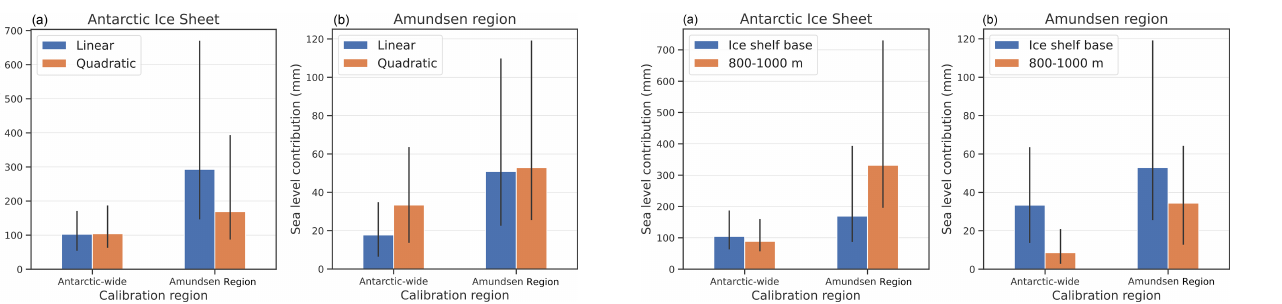
Figure 11. Projections of the sea level contribution of the AIS (a) and Amundsen Region (b) for SSP5-8.5 for all calibrated ESM-RF combinations using the quadratic parameterisation. The bars indi- cate the median sea level contribution in 2100 relative to 1995– 2014. The thermal forcing and basal melt sensitivity are based on ocean temperature at two different depths: 100m centred around the mean depth of the ice shelf base (blue) and 800–1000m depth (orange). The black lines indicate the 17th–83rd